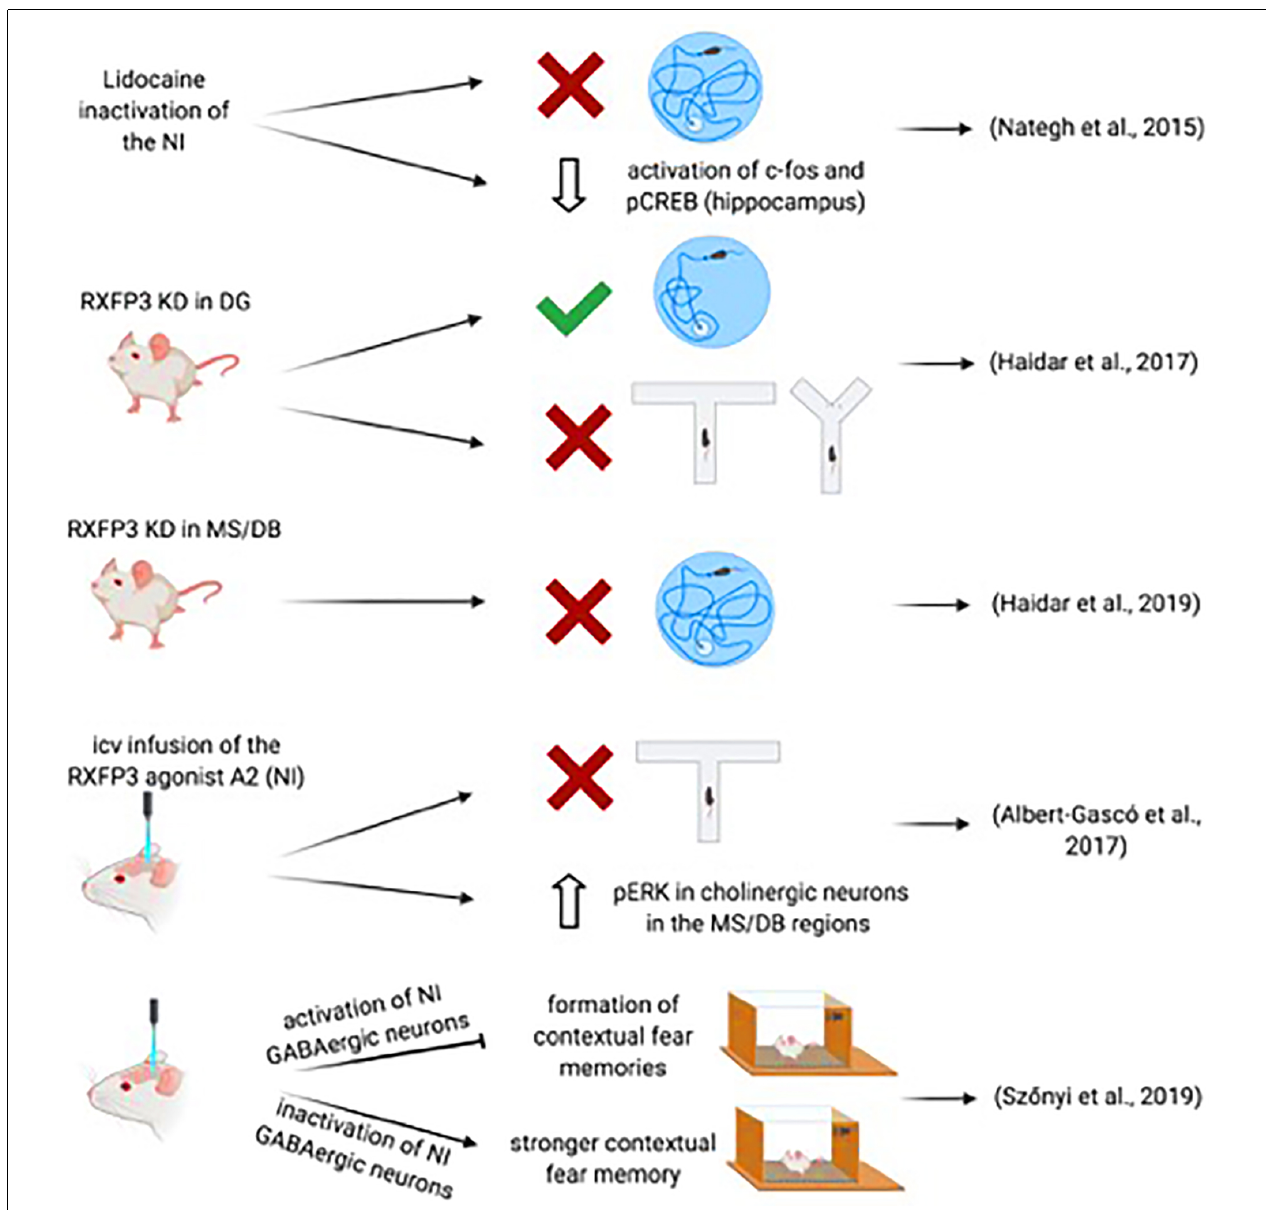
FIGURE 3 | Summary of data demonstrating the involvement of the NI-RLN3-RXFP3 system in declarative and contextual